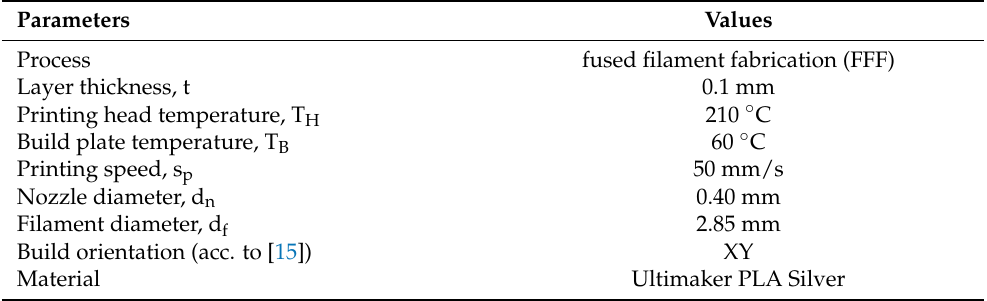
Table 2. The 3D printing parameters.